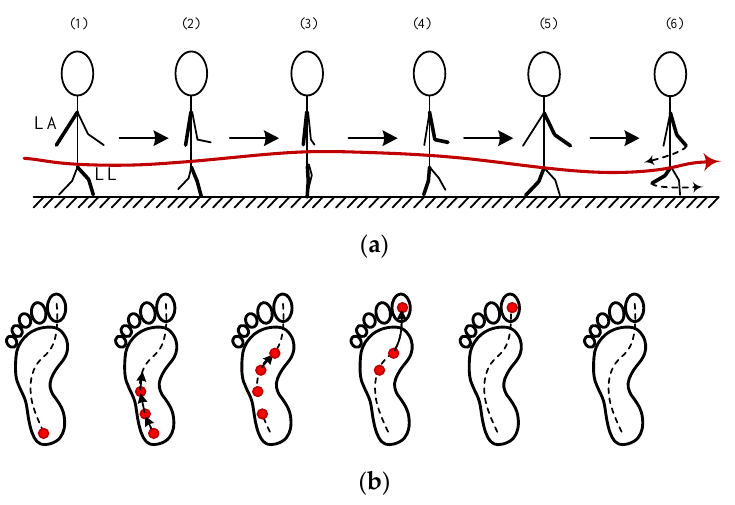
Figure 3. Breakout of a walking cycle for left leg (LL) stance into six sequences: ( a ) gait phases with the illustration of left arm (LA) balance and the oscillations of the body center of mass, ( b ) progression of the center of pressure with red circles indicating applied pressure.